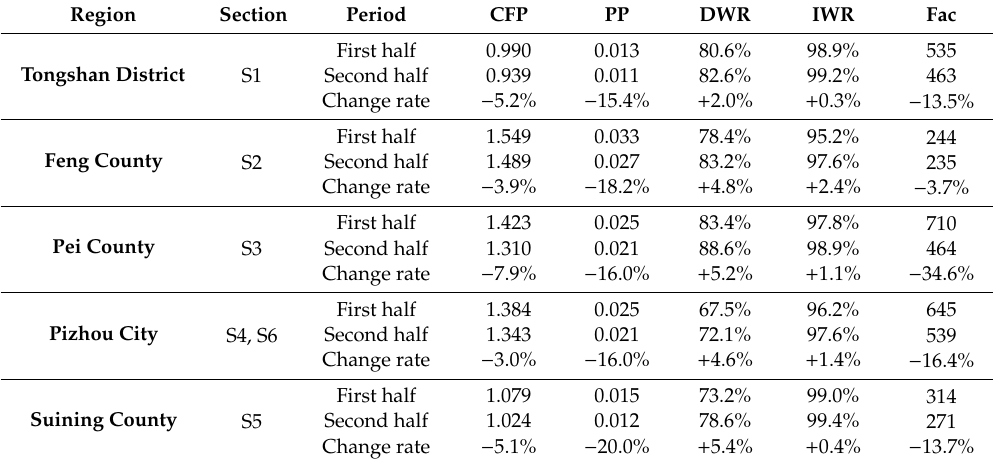
Table 5. The influencing factors of each district and county in